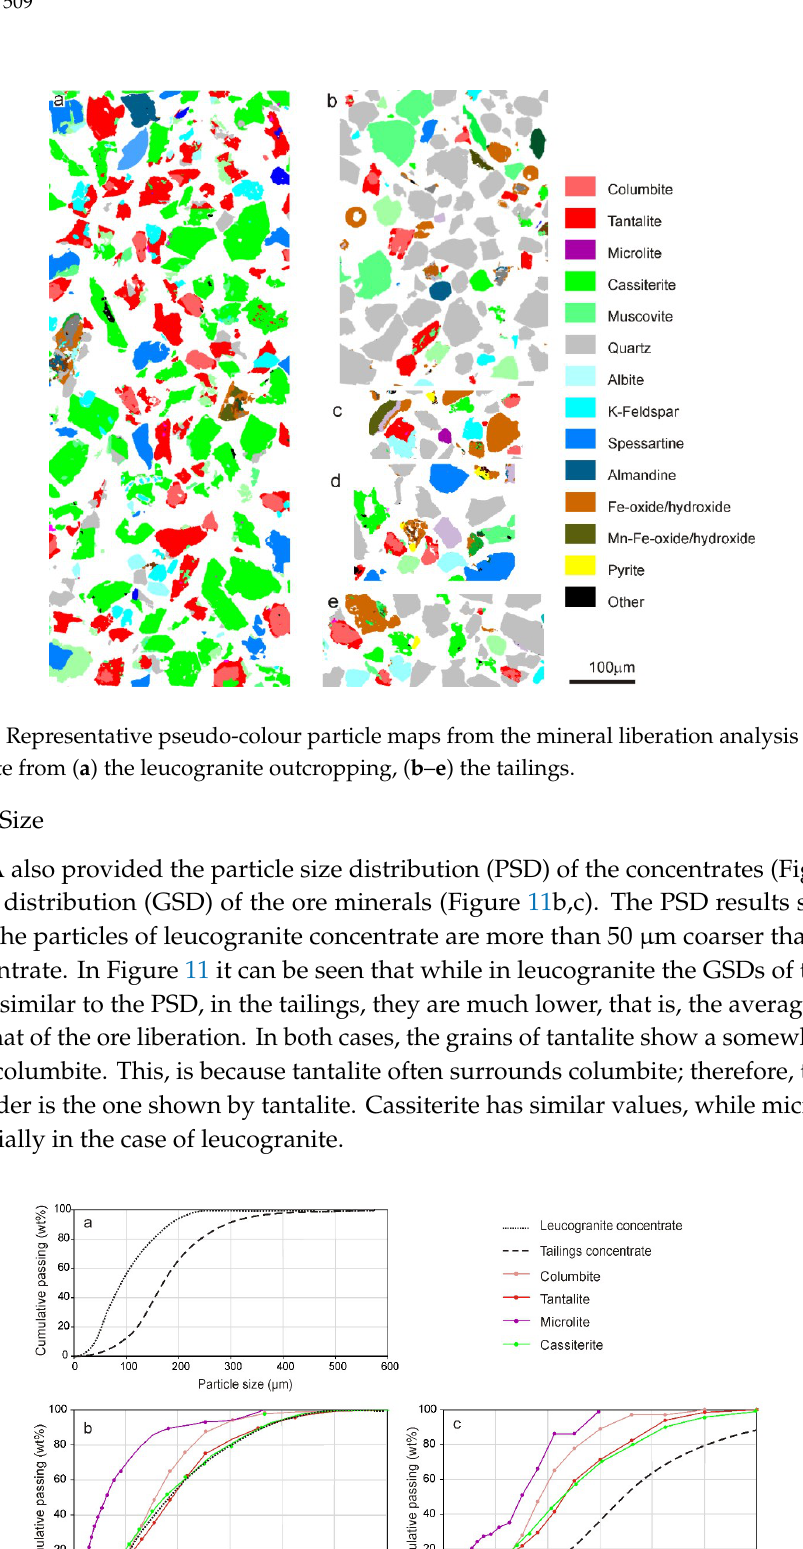
In the concentrates the most abundant ore mineral was cassiterite, with 53.6 wt% in the